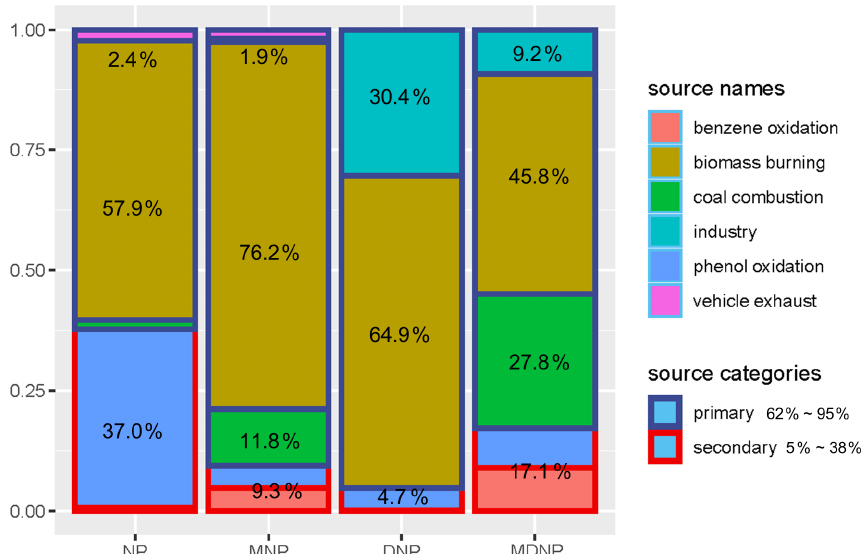
Figure 8. Contribution of primary emission (in dark blue border) and second formation (in red border) of nitrated phenols. Primary emission was classified as biomass burning, coal combustion industry, and vehicle exhaust, which were resolved by non-negative matrix factorization (NMF). NPs in the legend referred to dinitrophenol (DNP), methyl-dinitrophenol (MDNP), methyl-nitrophenol (MNP), and nitrophenol (NP). Secondary formation of nitrophenol was categorized as benzene oxidation ( < 1%) and the oxidation of primarily emitted phenol (phenol oxidation, 37%). It was noticeable that nitrophenol derived from the primary phenol oxidation was much more important than the pathway from traditional benzene oxidation in the winter of